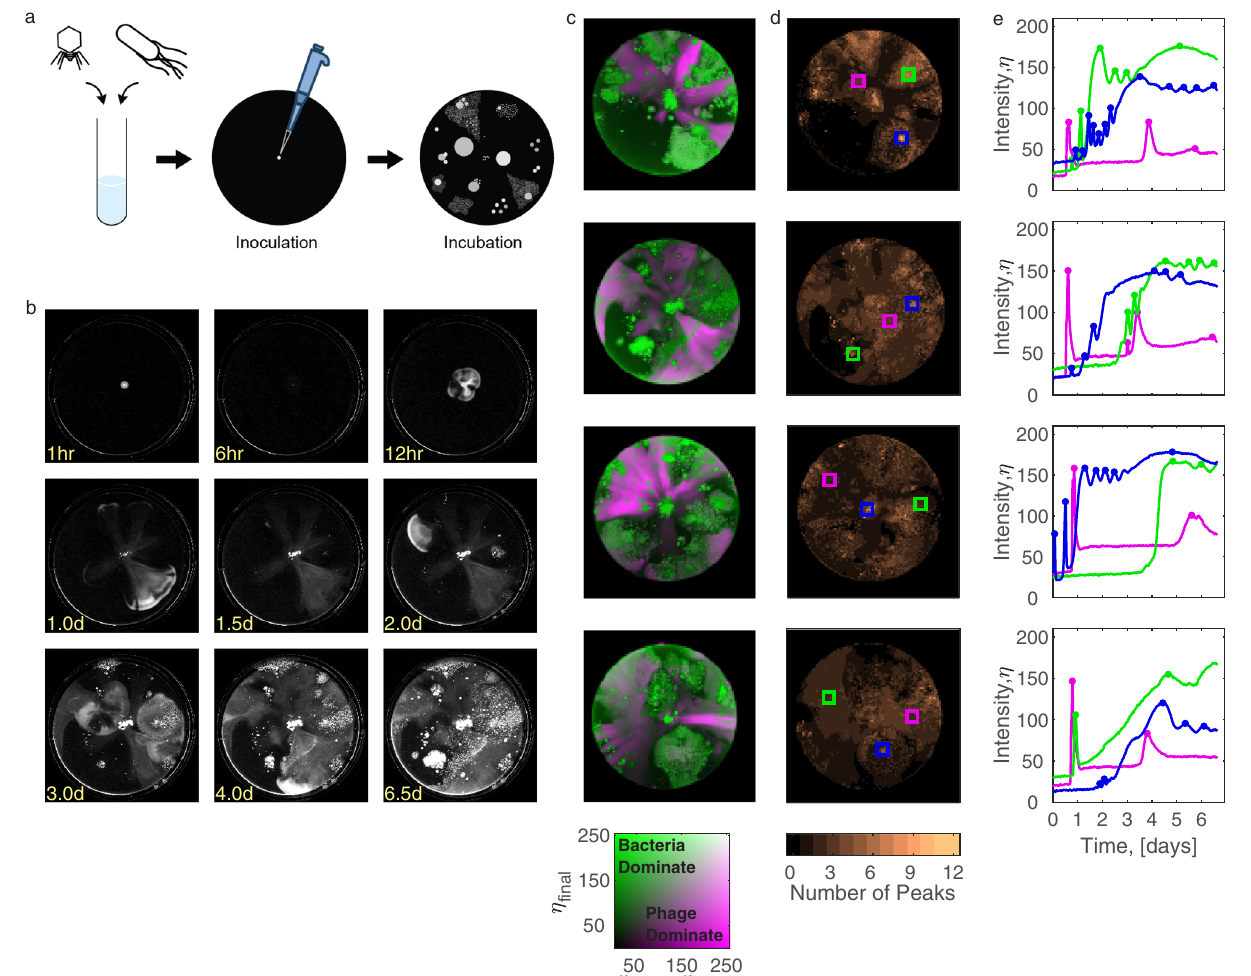
Fig. 1 | Bacteria-phage coevolution on swimming-plates leads to multiple adaptive cycles with neither species taking over. a Experimental setup for long- termevolution:mixturesofmotileMG1655cellsandT7virionsareinoculatedatthe centeroffourreplicateswimmingplates(14cmdiameter,70mlof0.3%agarinLB) and incubated at 30°C for 7 days. b Sample dark- fi eld images of a representative replicate at different time points. c A composite heatmap of fi nal pixel intensity ( η fi nal ,green)andthedifferencebetweenthemaximaland fi nalintensity( η max - η fi nal , magenta), representing bacterial or phage dominance respectively on each of the